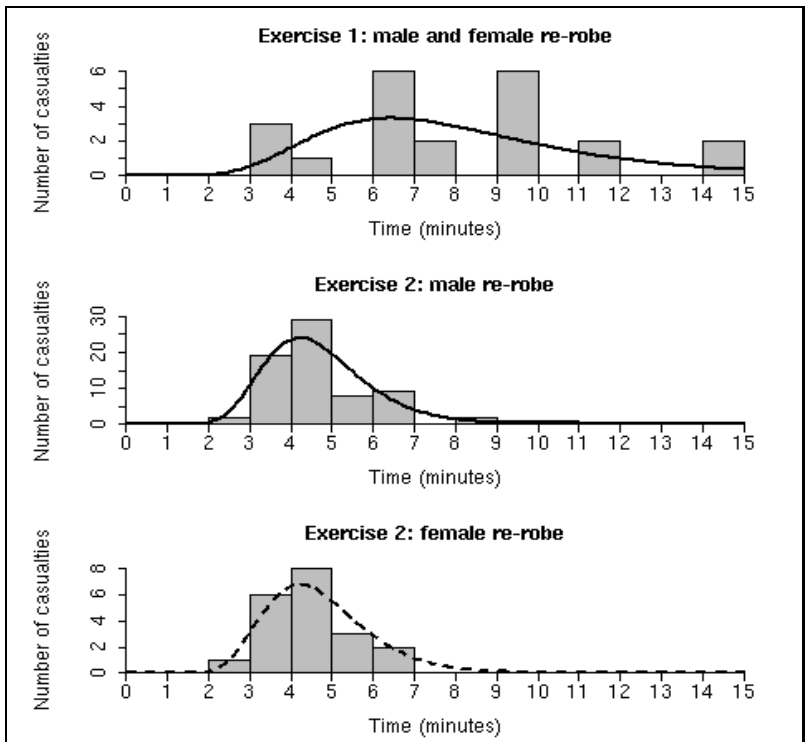
Figure 4. Histograms of the re-robe durations for both exercises. The solid black lines show the baseline ( middle ) and worst-case ( top ) re-robe distribution fits to the data. The dashed black line overlays the baseline fit on the female data in order to highlight their similarity. The worst-case fit is based on a combination of male and female data from Exercise 1 whereas the baseline fit is based only on the male data from Exercise